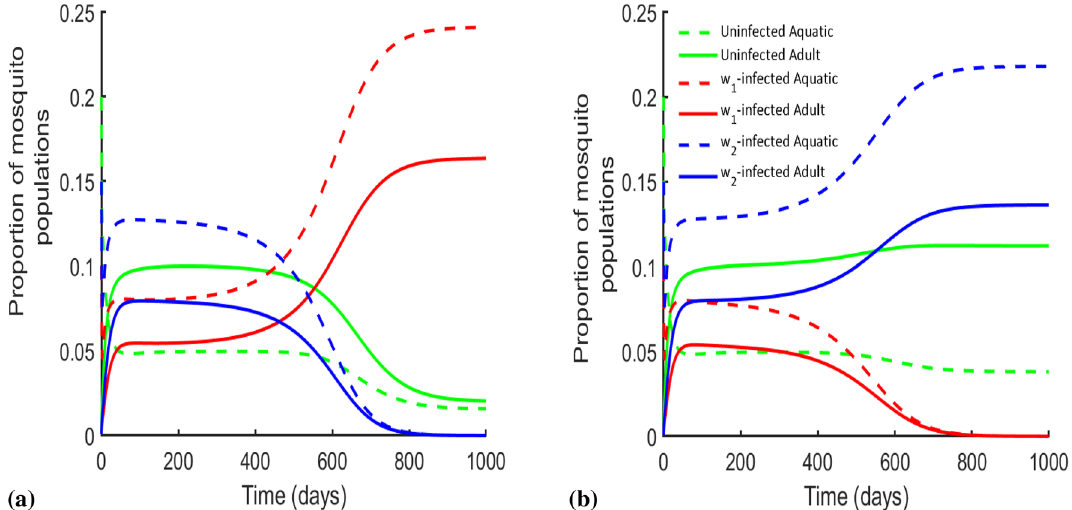
Figure 4. The numerical simulations showing pseudo existence of e uw 1 w 2 . For R 0 u , R 0 w 1 , R 0 w 2 > 1 , using = 41.5 and ρ w = 30 , (a) Showed that mosquitoes with strains w Au (with maternal transmission ρ u = 10 , ρ w 1 2 of η w 1 w 1 = 0.97 ), w Mel ( η w 2 w 2 = 0.97 ) and wild-type exist for a time and then one of the Wolbachia infected mosquitoes- w Mel is eliminated by the other dominating w Au-infected mosquito population showing instability. (b) Showed that an infinitesimal decrease in the reproductive rate of w Au-infected mosquitoes, i.e. ( ρ w 1 = 41.4